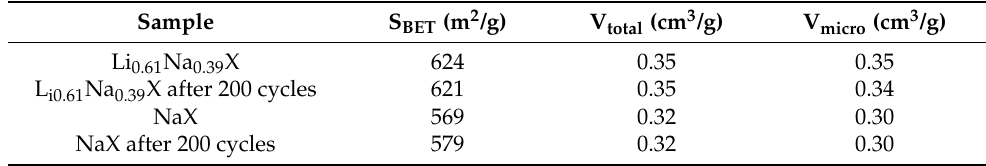
Table 8. Textural properties of the zeolites before and after aging